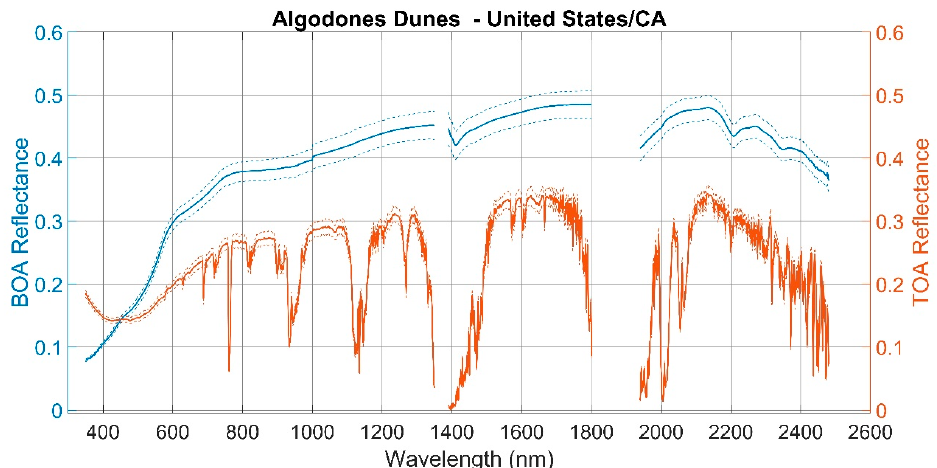
Figure 4. In the y -axis left and right side of the graph is presented, respectively, the BOA and TOA reflectance of Algodones Dunes measured in situ in March 2015.